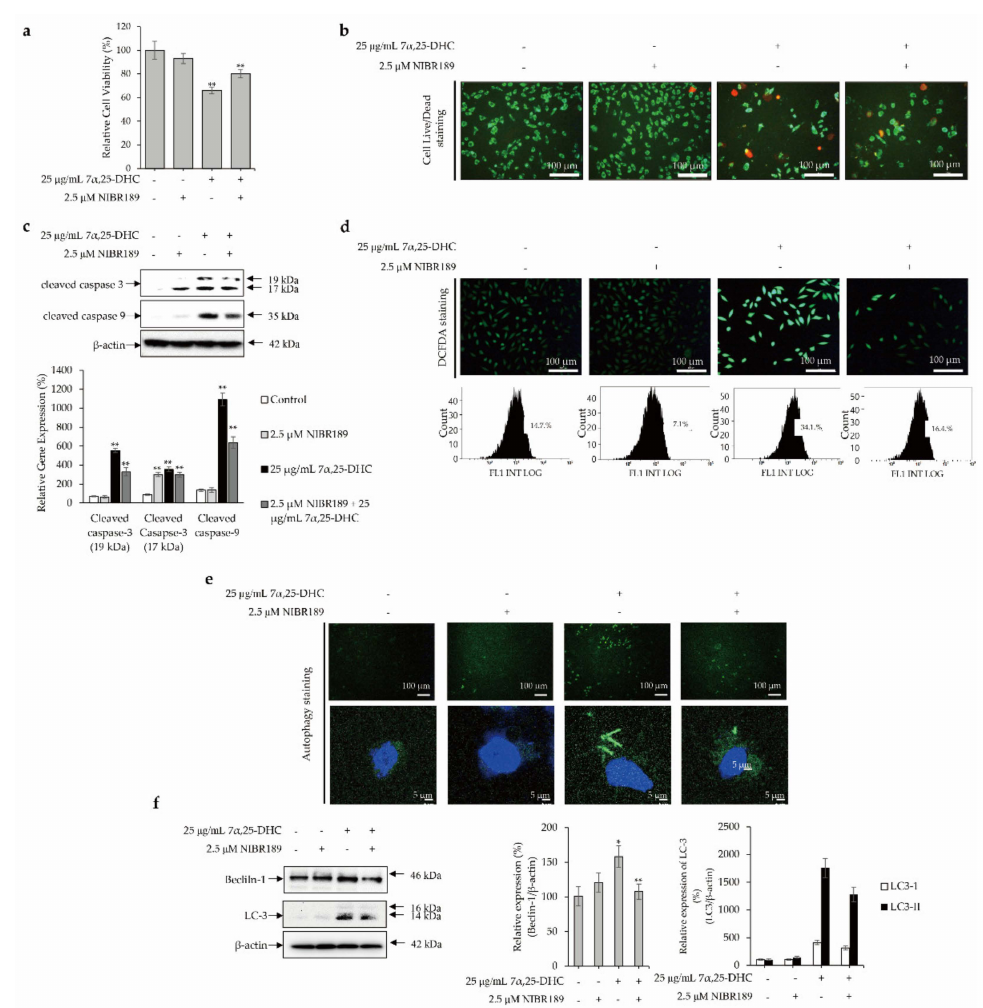
Figure 8. GPR183 regulates 7 α ,25-DHC-induced oxiapoptotic cell death in L929 cells. L929 cells were incubated with 25 µ g/mL 7 α ,25-DHC in the presence or absence of 2.5 µ M NIBR189 (chemical inhibitor of GP183) for 48 h. Results of western blot were presented as the relative ratio of target protein/ β -actin, * p < 0.05 and ** p < 0.01. β -actin was used as an internal control. ( a )